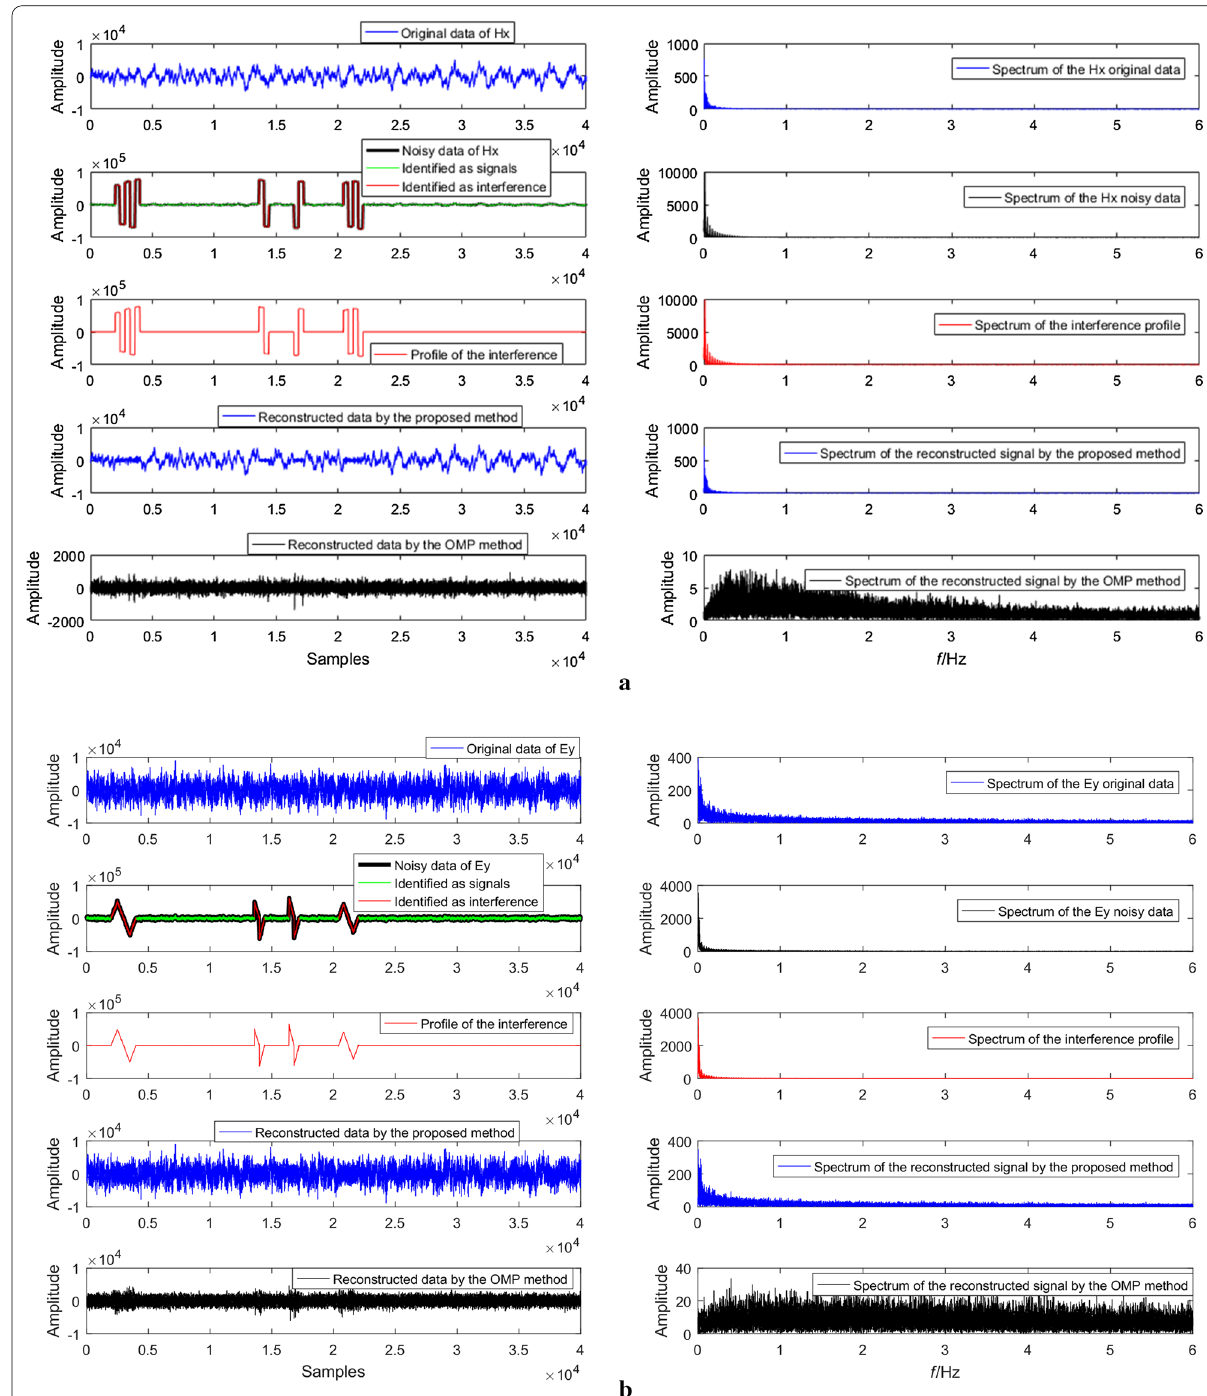
Fig. 4 The EMTF data are disturbed by a noisy signal with a square wave interference of the Hx and b charge and discharge triangle wave interference of the Ey; c is a comparison of the apparent resistivity-phase and error curves. Curve 1 is the original data, curve 2 is the noisy data, curve 3 is the RR method, curve 4 is the OMP-based overall method, and curve 5 is the proposed